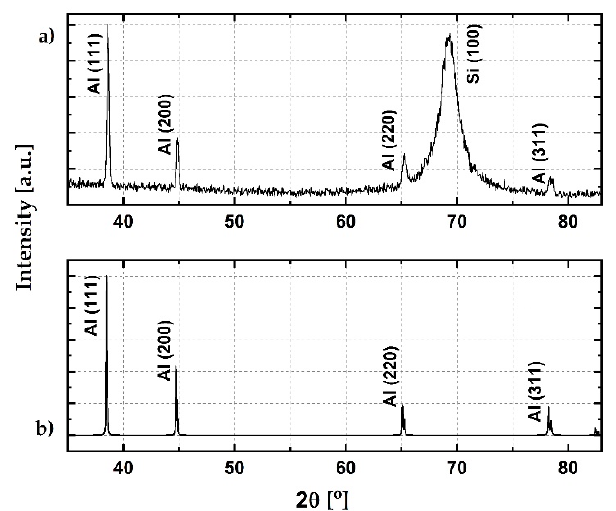
Figure 5. ( a ) Obtained XRD diffractogram; ( b ) theoretical diffractogram for aluminum.